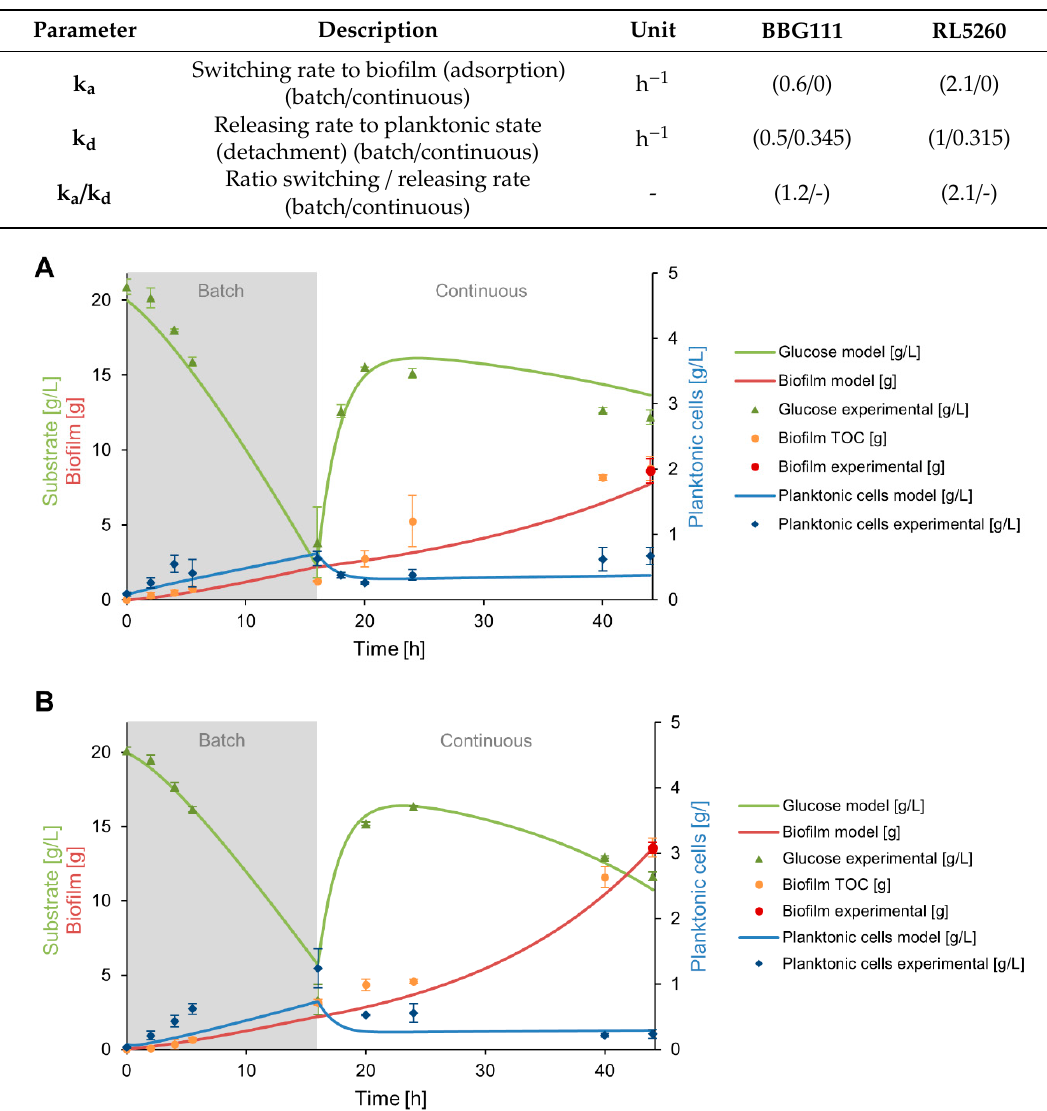
Figure 7. Glucose consumption, planktonic cells and biofilm development predicted by the model for the two-compartment system for BBG111 ( A ) and RL5260 ( B ). The model results are drawn with a continuous line and the experimental results are added as point references for comparison.